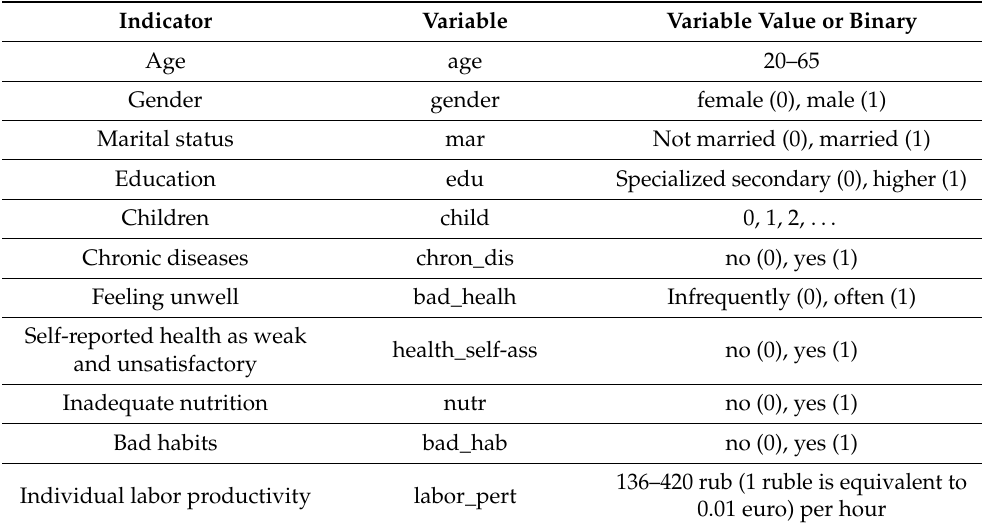
Table 1. Indicators, variables and range of variable